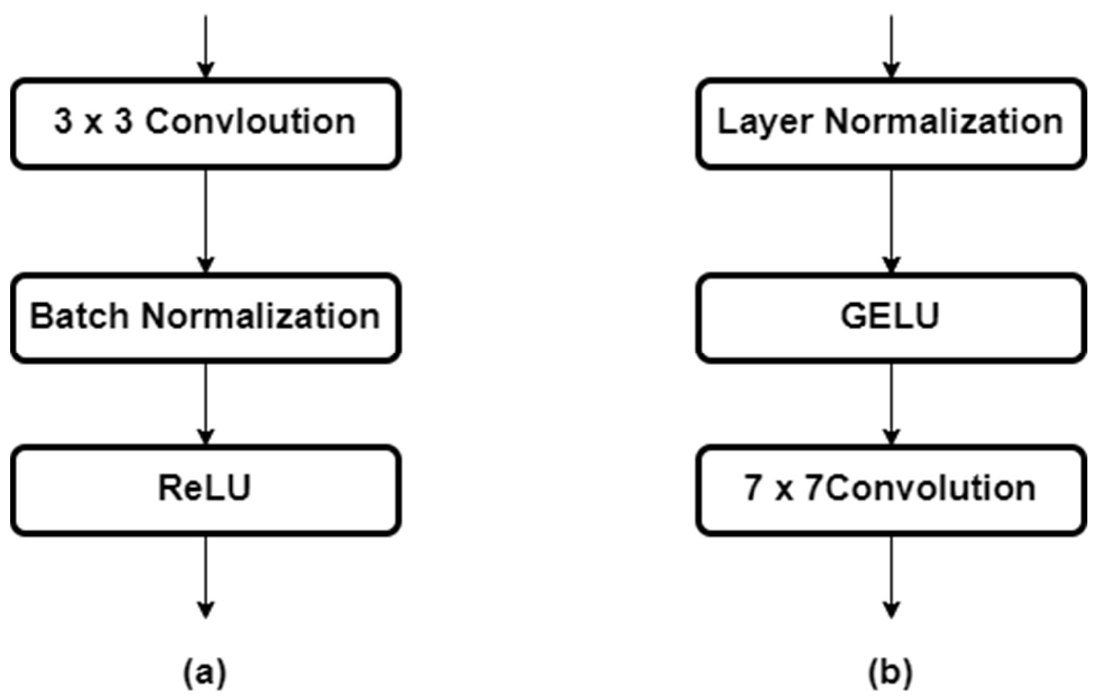
Figure 4. Typical convolution block ( a ) and pre-activation convolution block with layer normalization with 7 × 7 convolution ( b ).